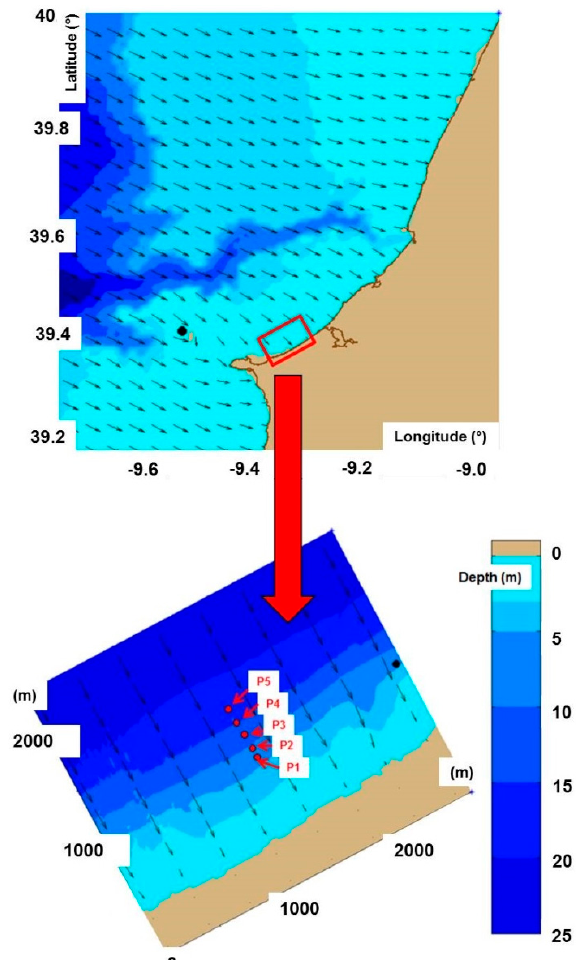
Figure 6. Location in geographical space (corresponding to the third computational level) of the high-resolution computational domain (corresponding to the fourth computational level) and the positions of the five reference points considered, denoted P1, P2, P3, P4, and P5, from shallow to deep water. In the background the bathymetric map is illustrated, while in the foreground the wave vectors corresponding to the most common propagation pattern.